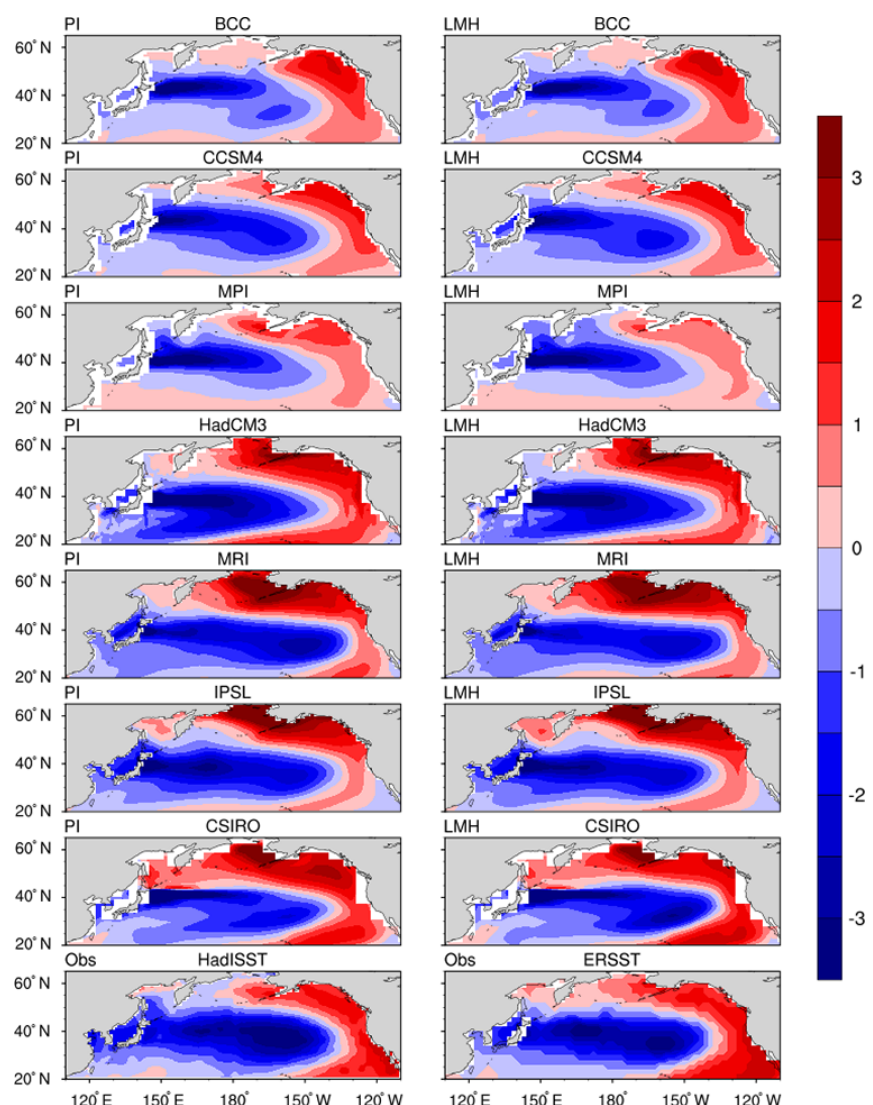
Figure 2. PDO SST patterns defined by the first empirical orthogonal function (EOF) of annual-mean SST for each GCM for the PI (first column) and LMH (second column) experiments compared with the HadISST and ERSST observations (bottom